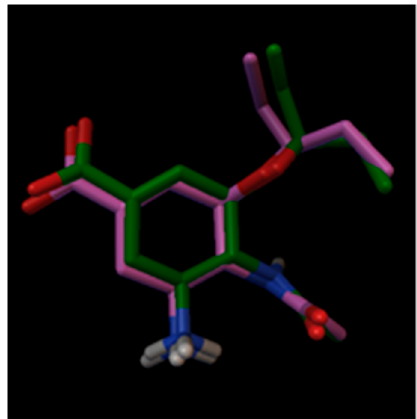
Figure 1. Co-crystallized (green) and redocked (pink) oseltamivir. The reliability of molecular docking was validated using the known X-ray structure of neuraminidase (NA) complexed with oseltamivir. The result demonstrated that the low root mean-square deviation (RMSD) was 1.12 Å between the docked and the crystal conformation of oseltamivir, which indicated the high reliability of AutoDock Vina.